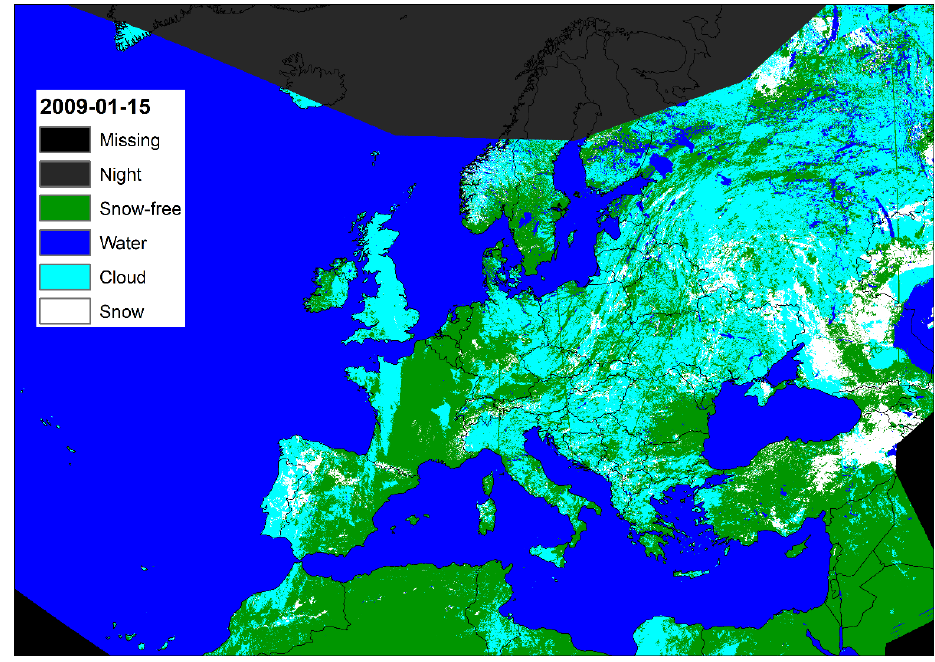
Figure 6. Example of a daily Level 3 product for 15 January 2009 (mid-winter).